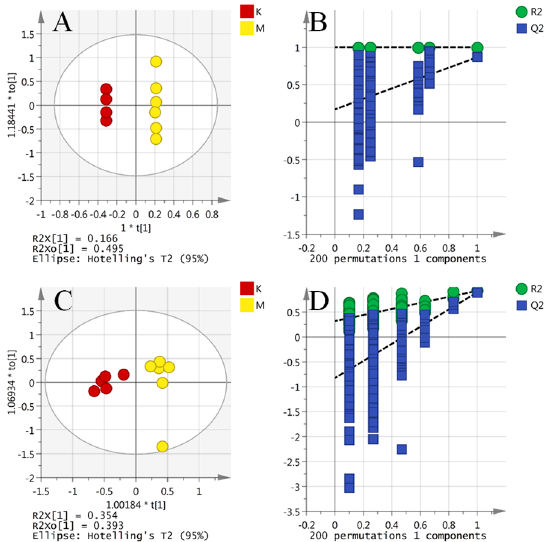
Figure 5. OPLS-DA score plot and validation plot of the OPLS-DA model of control group and model group. OPLS-DA score plot for the first two components showed the separation between the control group and model group. The fitness (R2Y) and prediction power (Q2Y) of this two-component model were 0.979 and 0.918, respectively (( A ) ESI + ; ( C ) ESI − ). Validation plot of the OPLS-DA model of control group and model group were obtained from 200 permutation tests. The intercepts of R2 were lower than the original point to the right, whereas those of Q2 were negative, indicating no signs of overfit (( B ) ESI + ; ( D ) ESI − ).